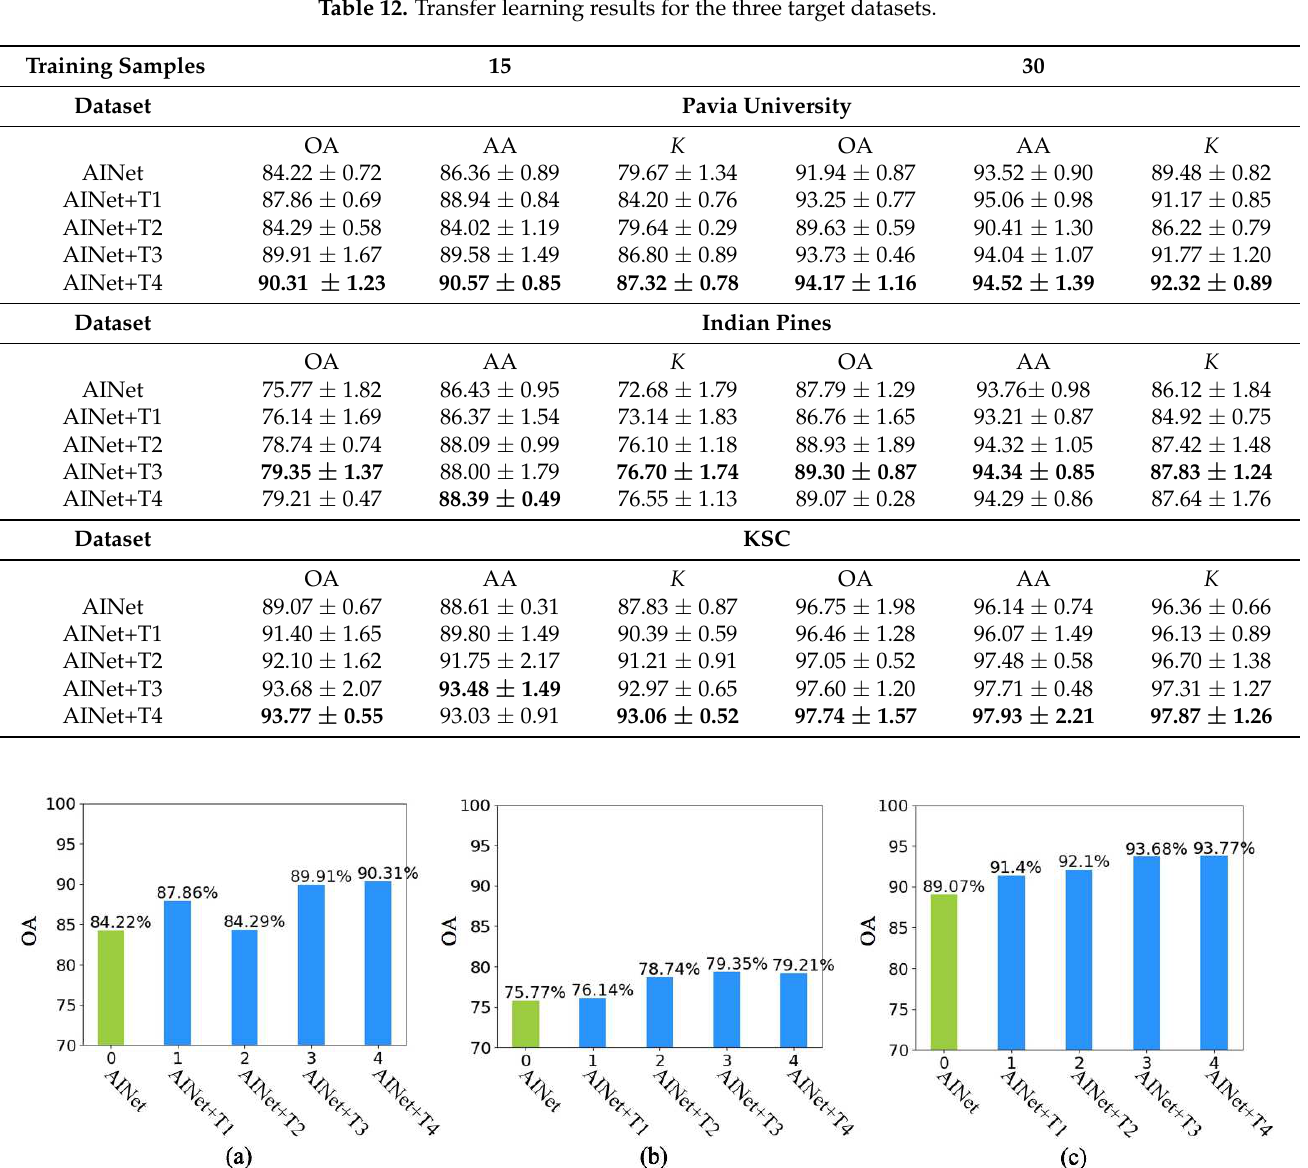
Table 12. Transfer learning results for the three target datasets.